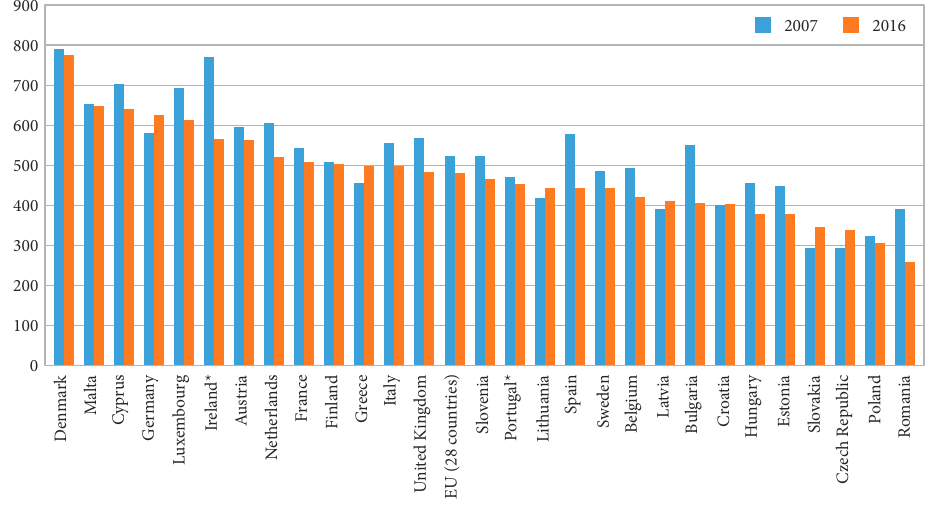
Figure 1. Municipal waste generated in EU countries (kilograms per capita) (source: Own elaboration based on Eurostat, 2018) Note: *2014 for Ireland and